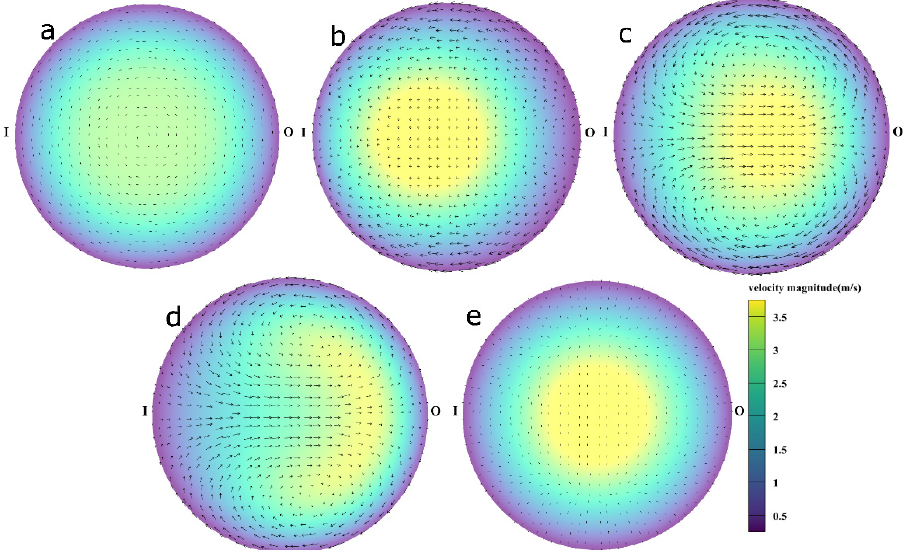
Figure 12. In the 45 ◦ channel at the conveying rate of 4.75 cm 3 /s, the profiles of the velocity magnitude and the velocity vectors on the five slices as indicated in Figure 8a. The slices ( a – e ) are from the inlet to the outlet.